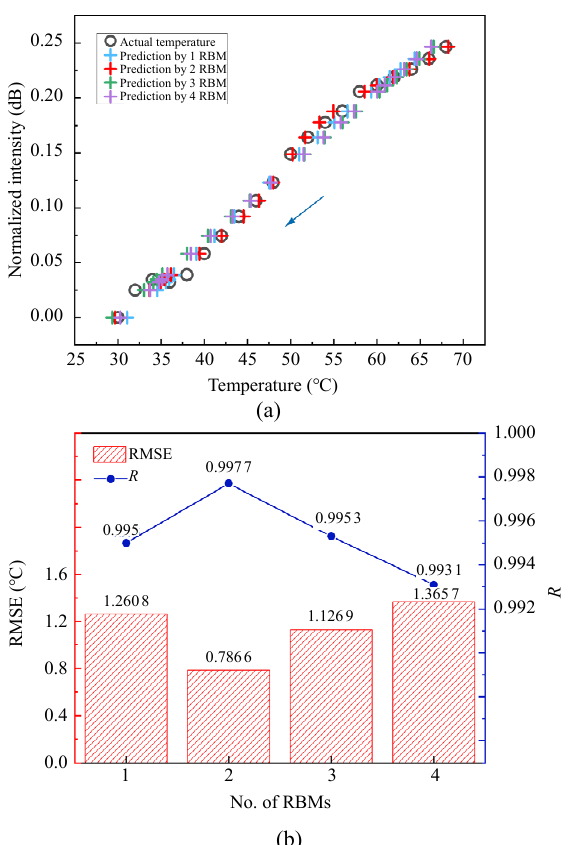
Fig. 6 Prediction skills for the temperature decreasing process with DBNs of different numbers of RBMs: (a) response curves and (b) evaluation metrics.